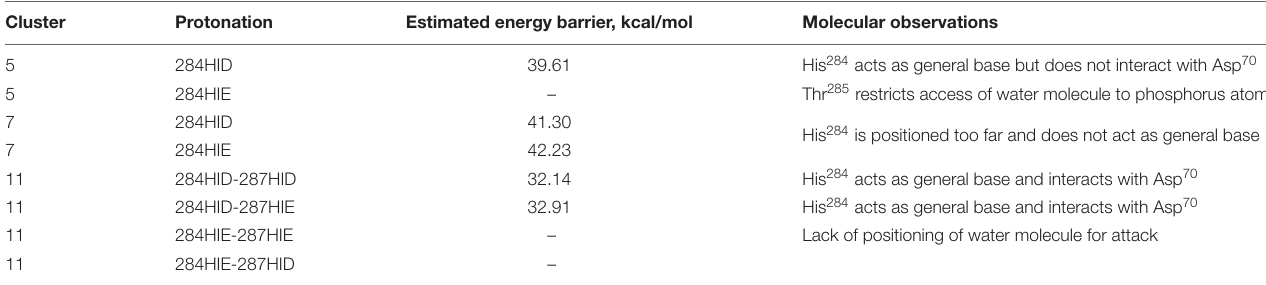
TABLE 2 | Results of QM/MM ranking analysis for BChE clone 14.